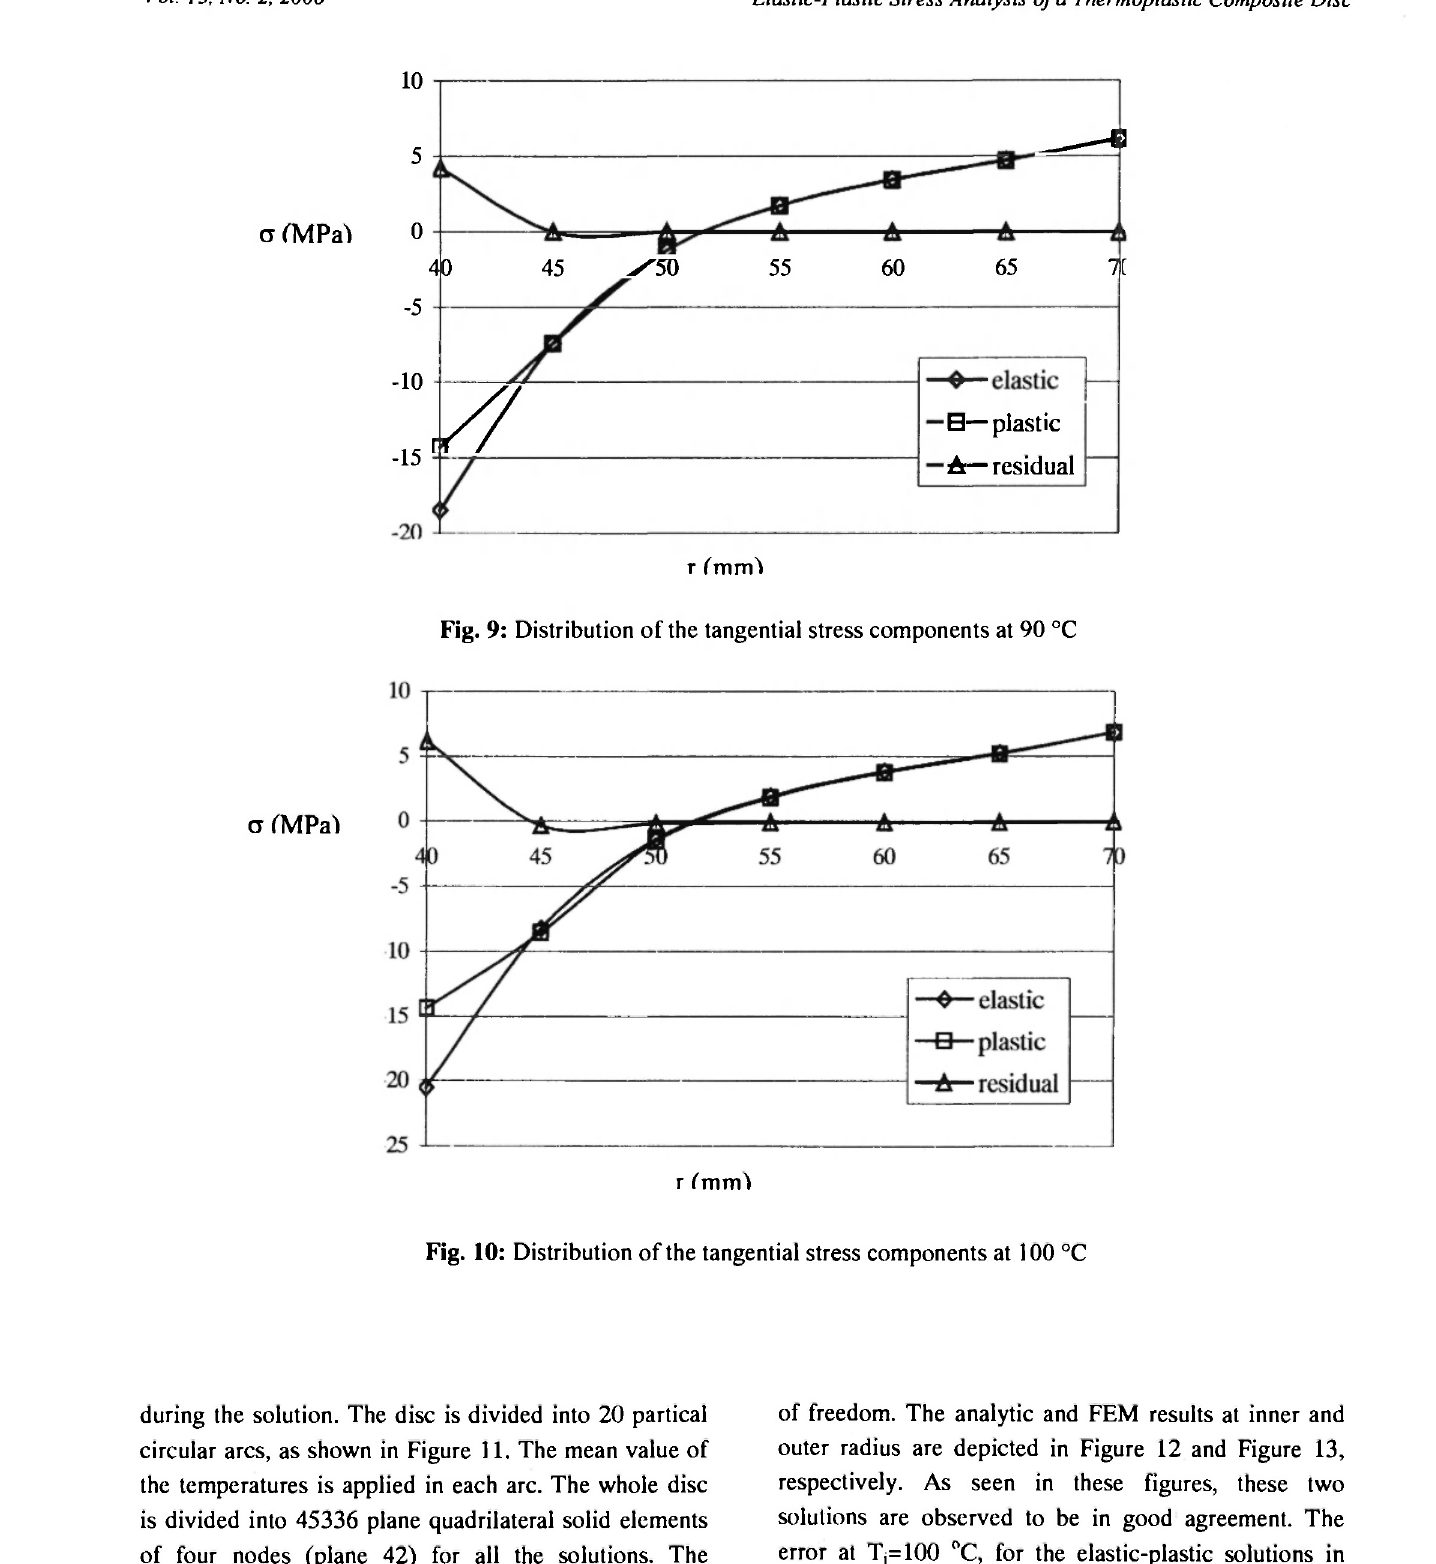
during the solution. The disc is divided into 20 partical circular arcs, as shown in Figure 11. The mean value of the temperatures is applied in each arc. The whole disc is divided into 45336 plane quadrilateral solid elements of four nodes (plane 42) for all the solutions. The number of nodes is 45724. Each node has two degrees